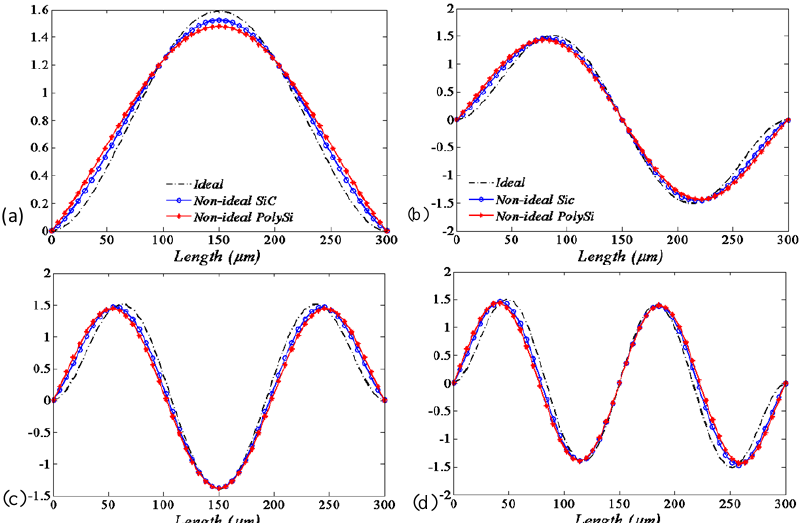
Figure 3. First four mode shapes corresponding to the natural frequencies of Table 3. ((Dashed) Ideal boundary conditions, (blue circle), (red star) non-ideal boundary conditions with the supports material of silicon carbide and polysilicon, respectively). ( a ) First; ( b ) Second; ( c ) Third; ( d )